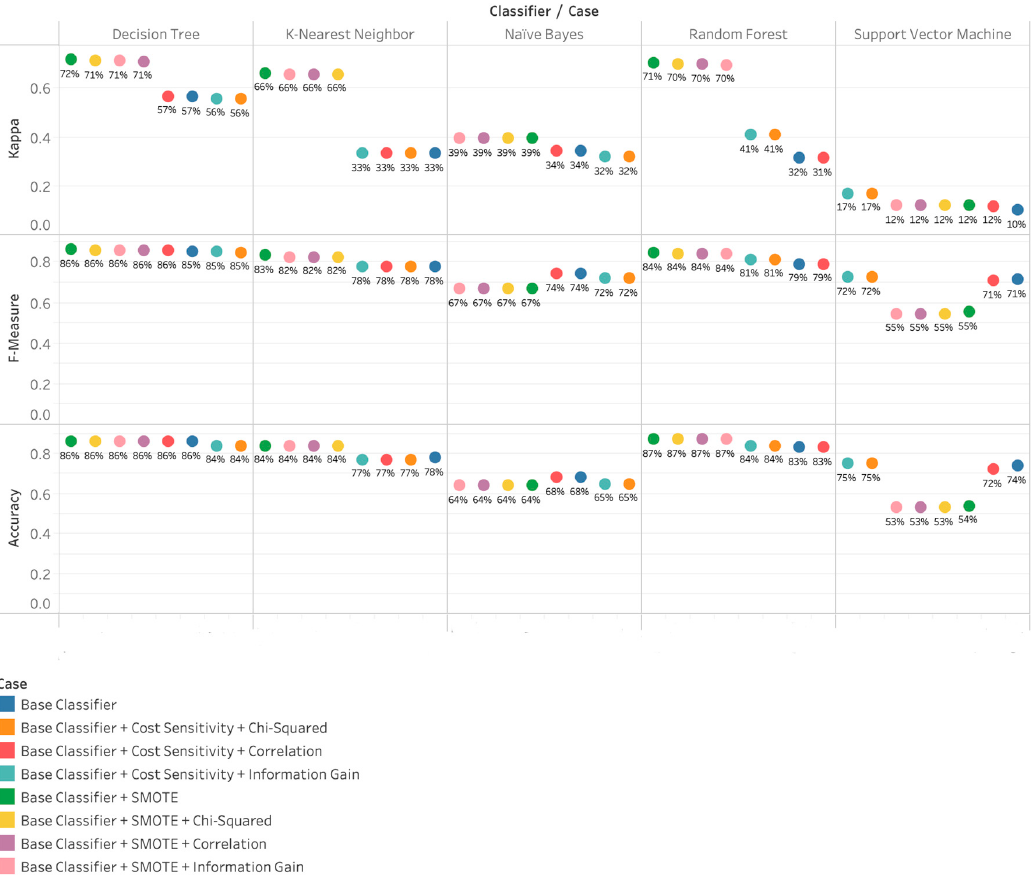
Figure 3. Results achieved with Bag of Words (baseline 1).